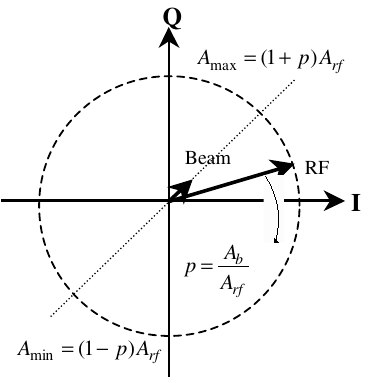
(cid:7) 1 Hz . Red r